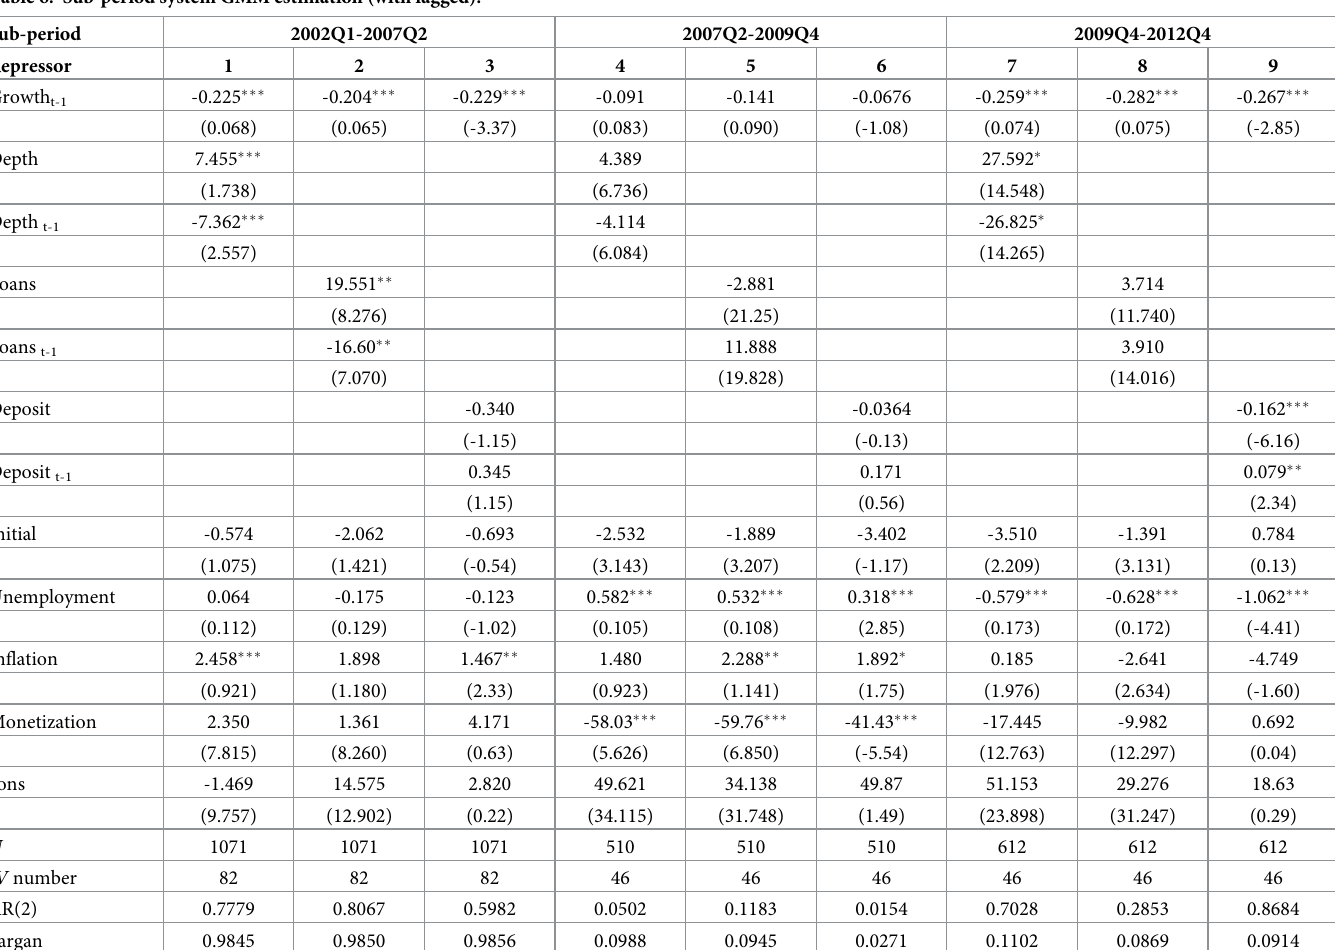
Table 6. Sub-period system GMM estimation (with